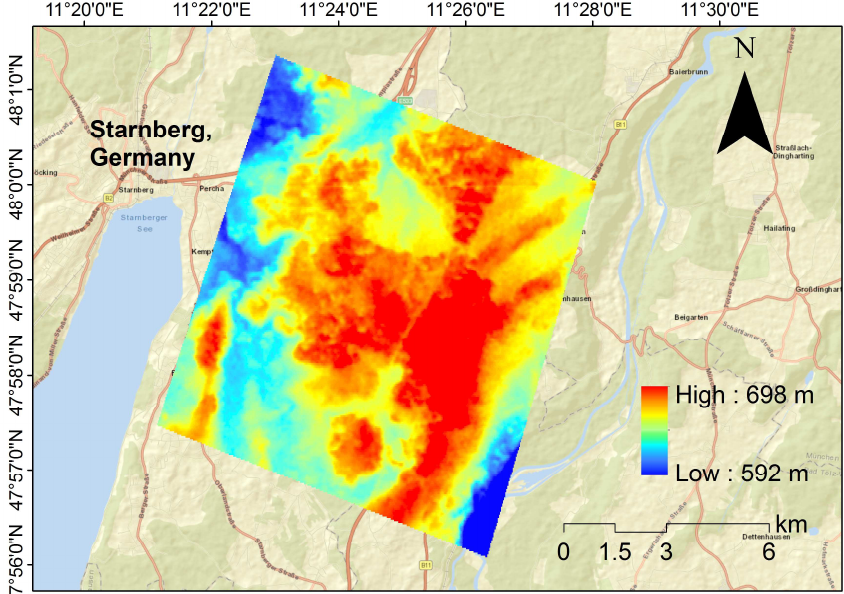
Figure 1. Location of the forest test